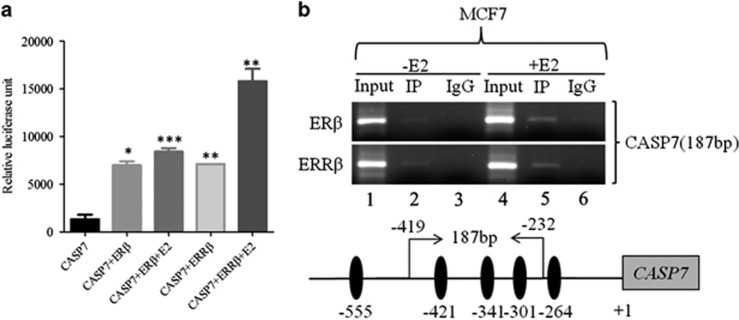
Other estrogen receptors can also regulate CASP7. (a) Relative luciferase activities of CASP7 after co-transfecting P-622, ERβ and ERRβ with subsequent E2 treatment for 24 h. (b) In vivo binding of ERβ and ERRβ in the CASP7 promoter through putative ERE sites with and without E2 treatment (upper panel). Schematic diagram of Chip PCR performed in CASP7 promoter (lower panel). *P<0.05. **P<0.01. ***P<0.001.